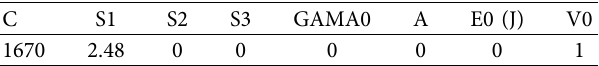
Table 3: Parameters of Gruneisen model.